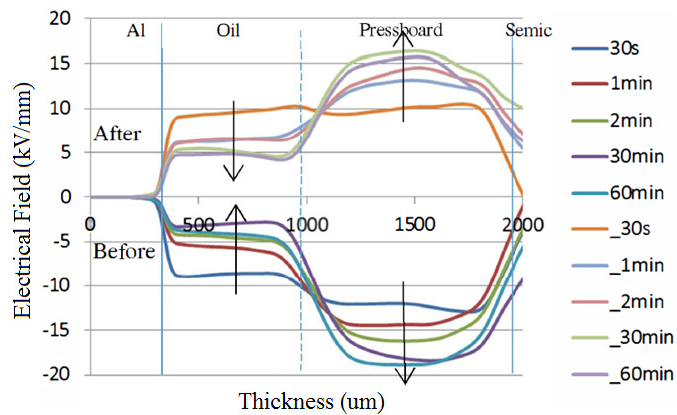
Figure 18. The “mirror image effect” of electric field distribution [35].